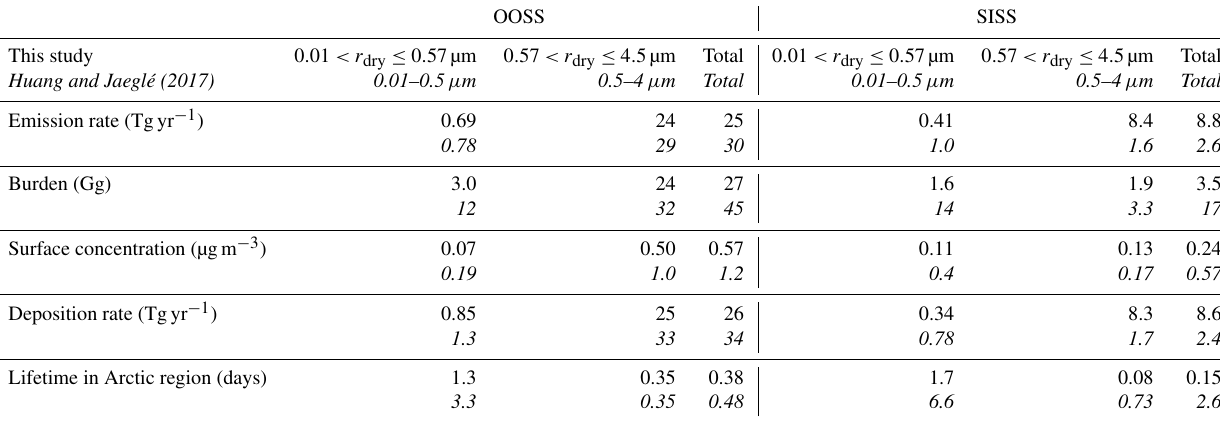
Table 3. Comparison between Arctic ( > 60 ◦ N) sea salt aerosol budgets simulated by this study and by Huang and Jaeglé (2017) (in italics) for 2005. All values refer to mass of total sea salt aerosol, defined as Na mass multiplied by 0.326, following Huang and Jaeglé (2017). Please see footnotes for definitions of each